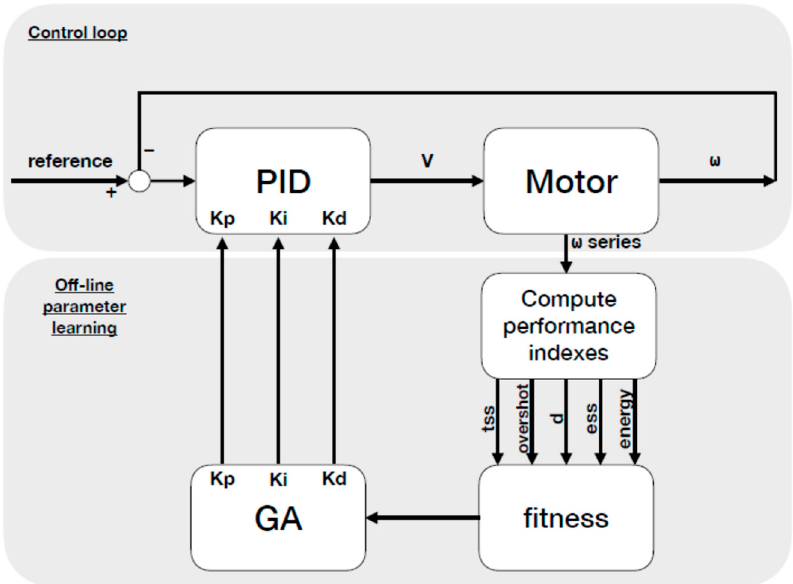
Figure 3. Block diagram that represents the control loop and que optimization procedure.